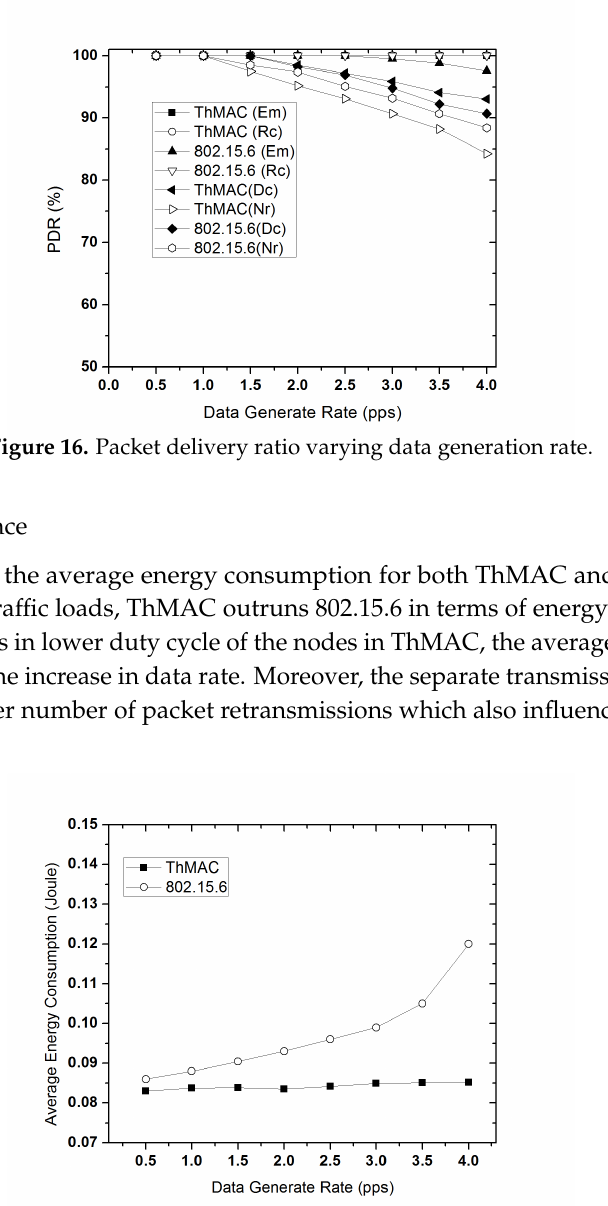
Figure 17. Average energy consumption varying data generation